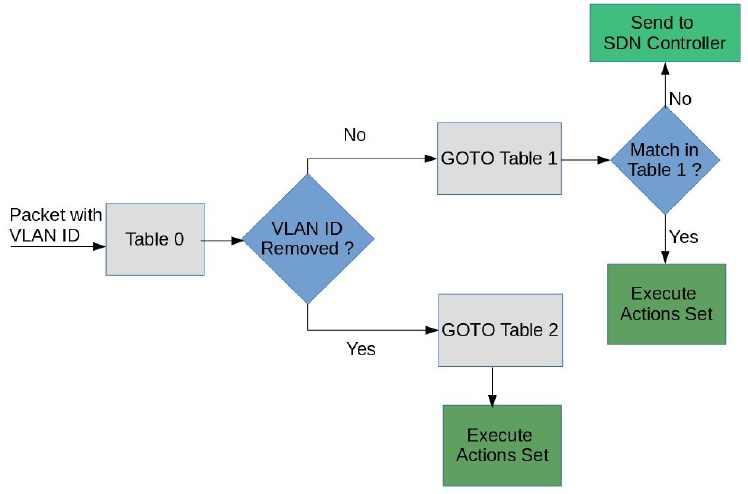
Figure 3. Packet processing in the SCS flow